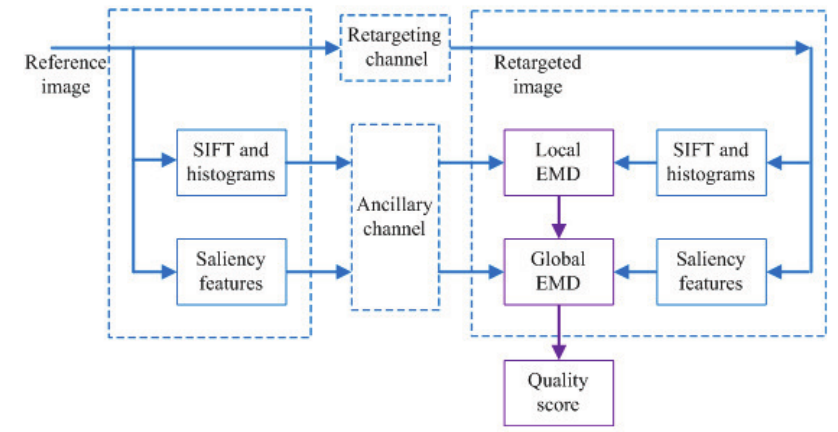
Figure 1. The framework of RR retargeted IQA by